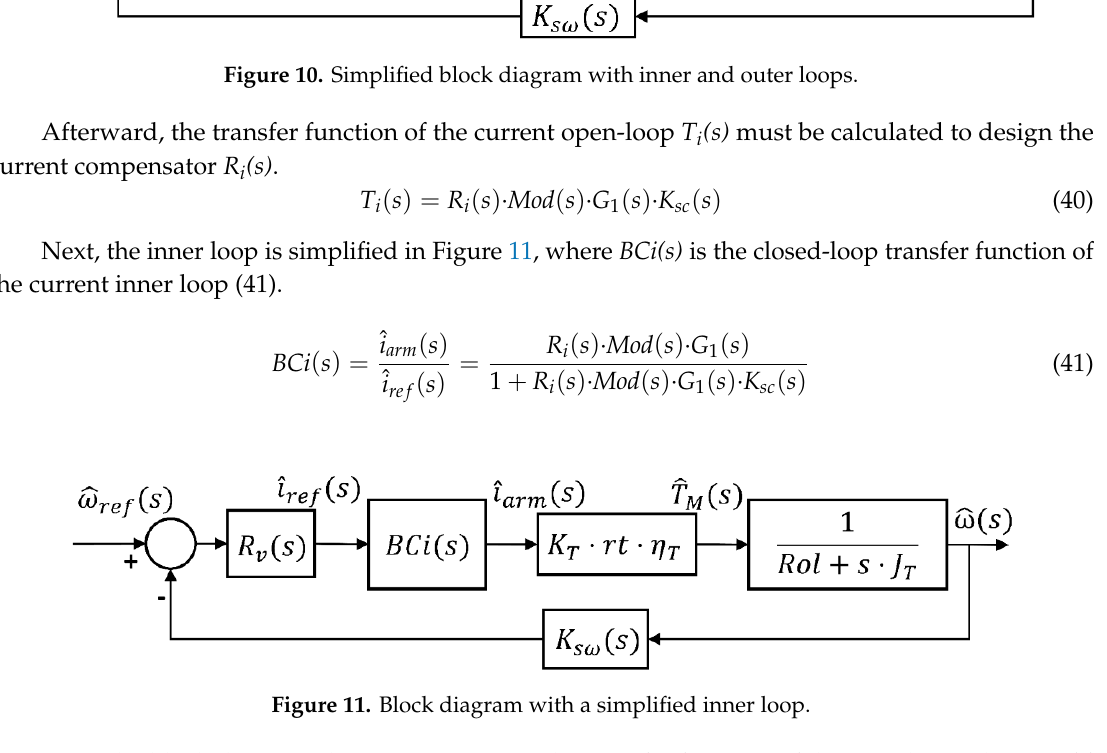
Table 1. Motor-vehicle compensators